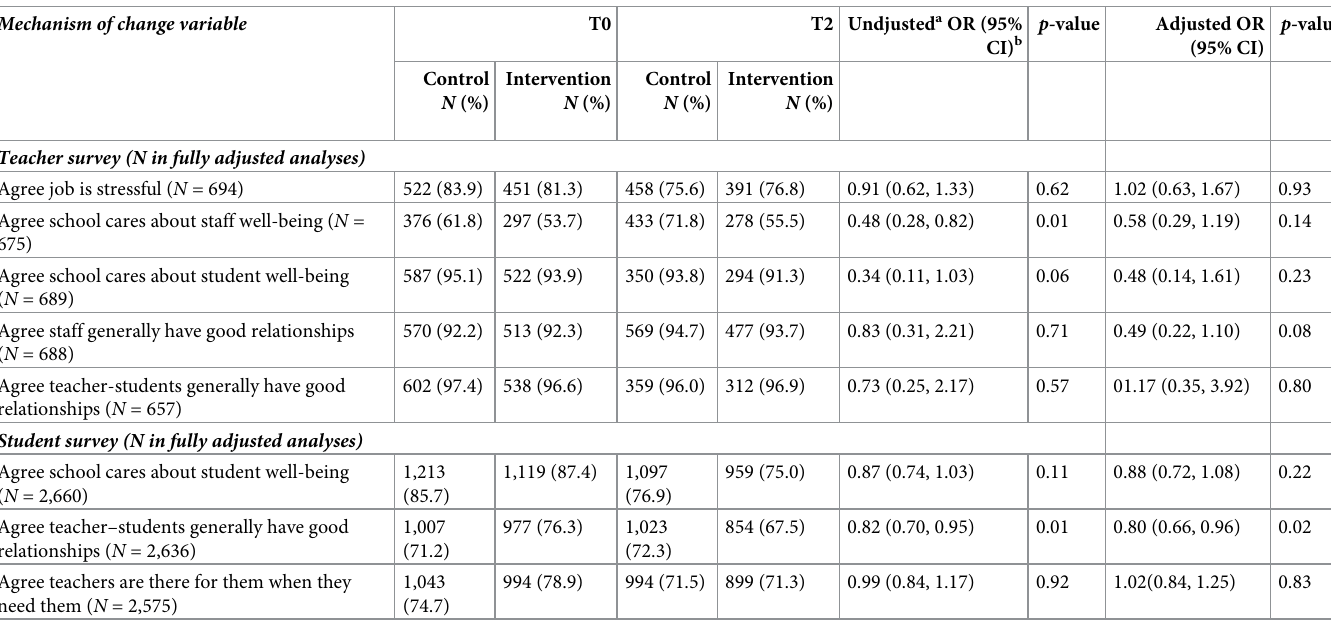
Table 3. Results for mechanisms of change